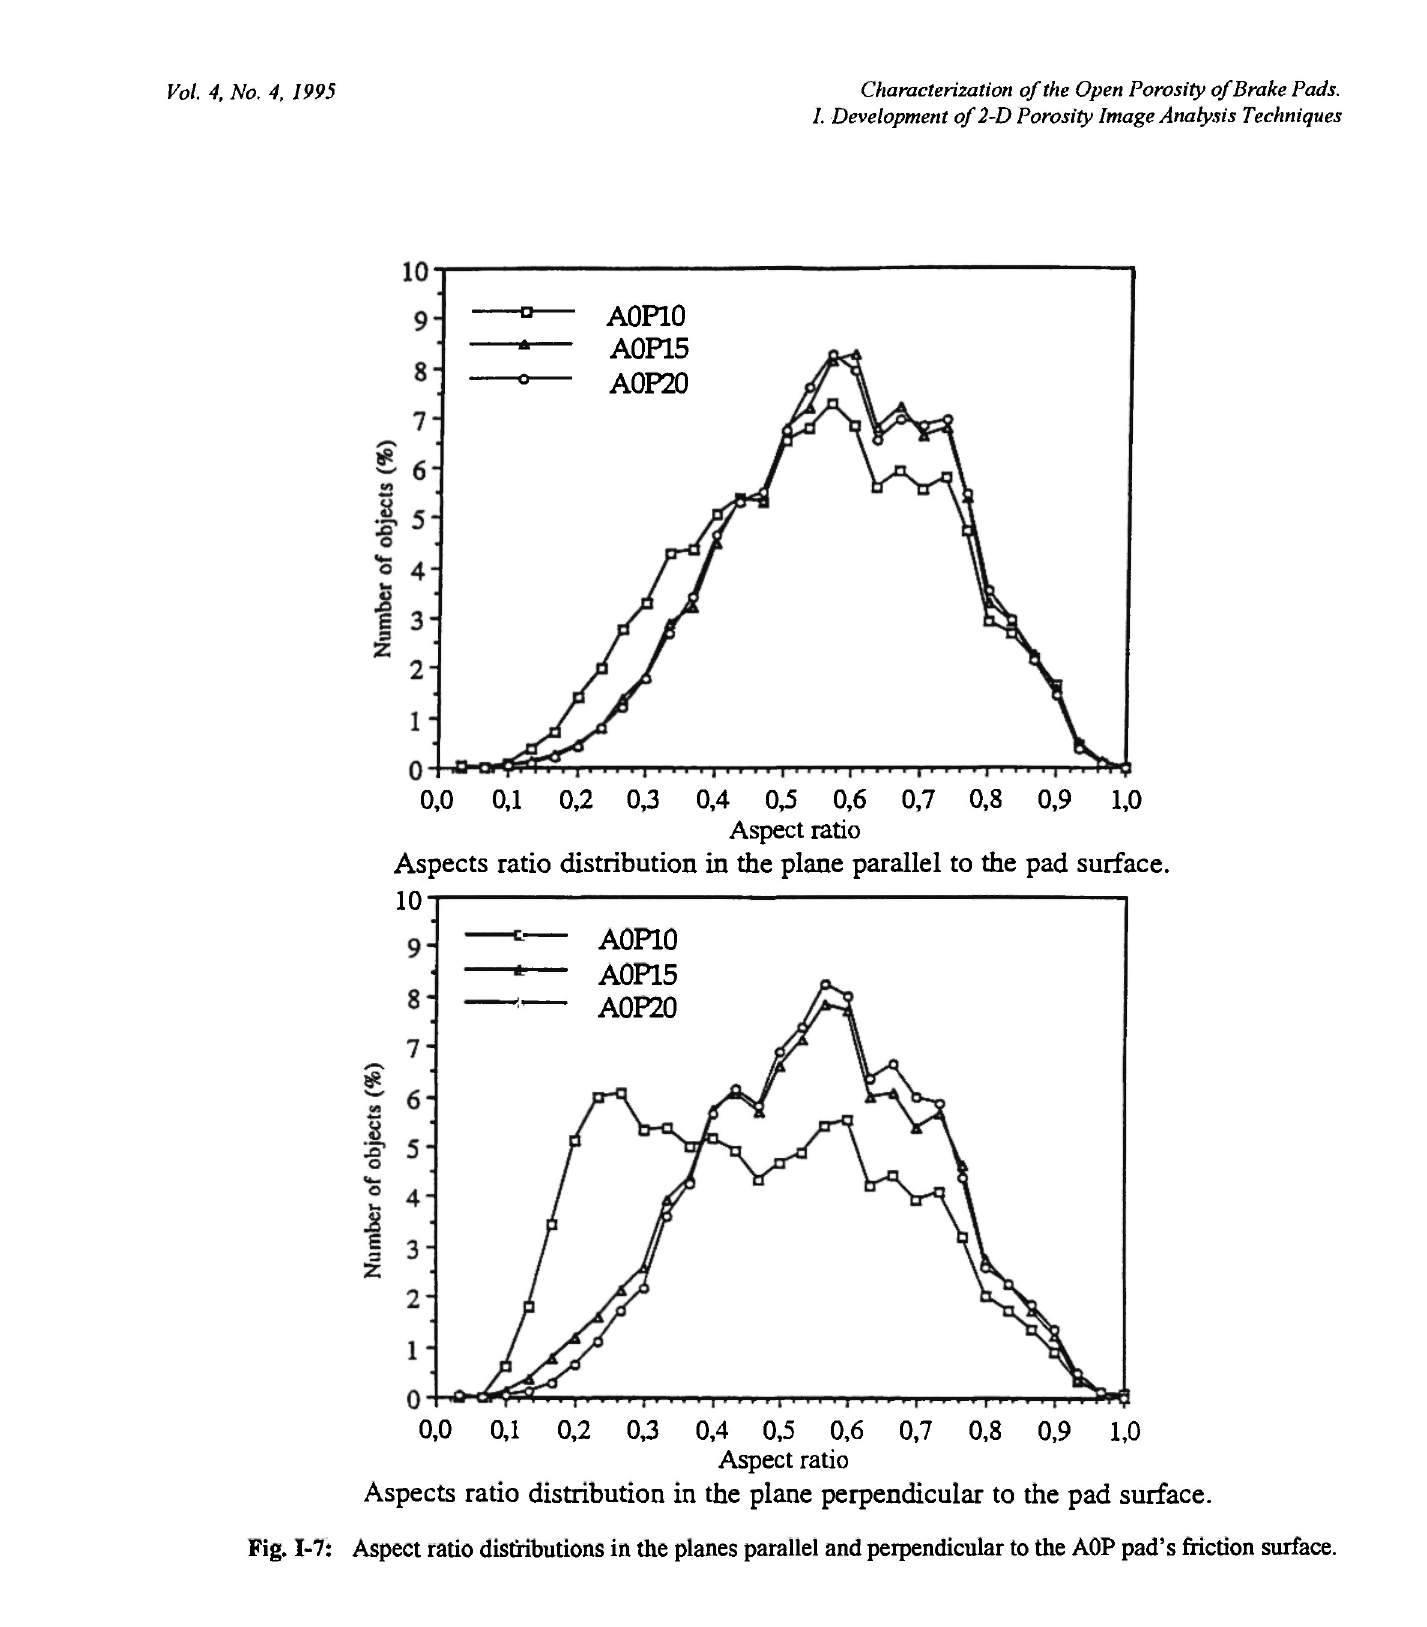
Fig. 1-7: Aspect ratio distributions in the planes parallel and perpendicular to the Α0Ρ pad's friction